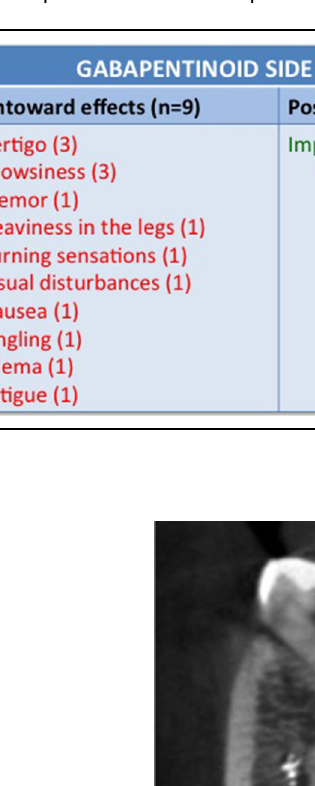
Table III. Side effects of gabapentinoids in the patient cohort (n = 10 patients out the 39 patients that were followed up).